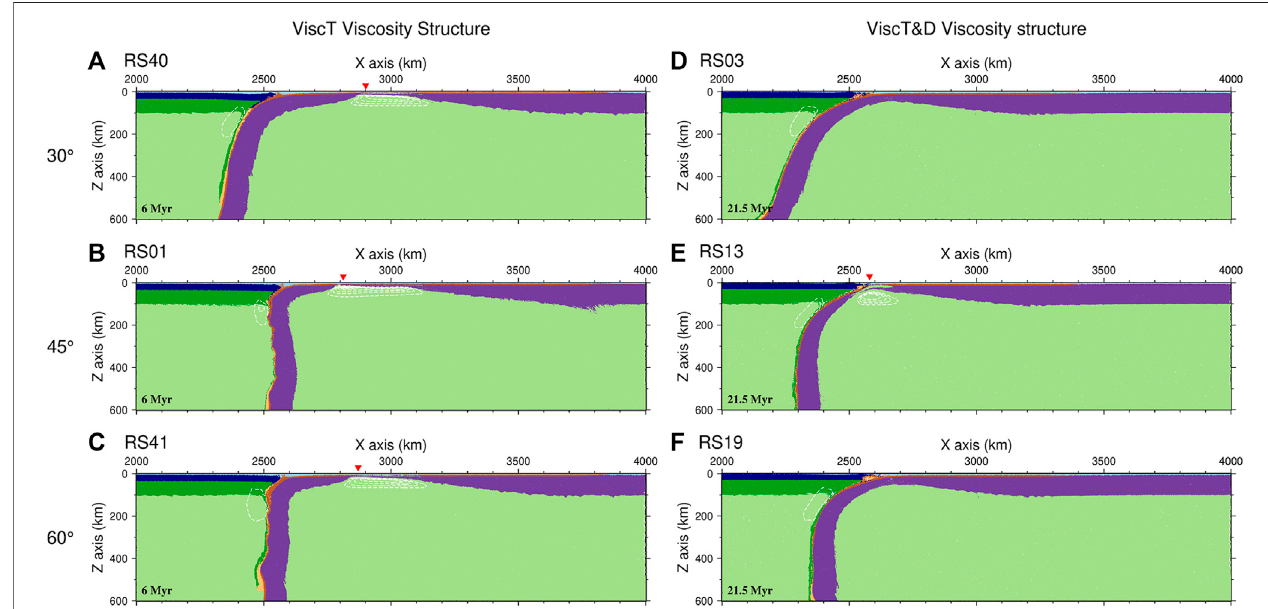
FIGURE 9 | The effects of different initial slab dip angles θ and mantle viscosity structures on the subduction of the MOR. We choose to show snapshots of the model when the foregoing oceanic plate is about to completely subduct. (A – C) show cases RS40, RS01 and RS41 at 6 Myrs when θ values are 30 ° , 45 ° and 60 ° , respectively, with the ViscT mantle viscosity structure. (D – F) show cases RS47, RS58 and RS19 at 21.5 Myrs when θ values are 30 ° , 45 ° and 60 ° , respectively, with the ViscT&D mantle viscosity structure.